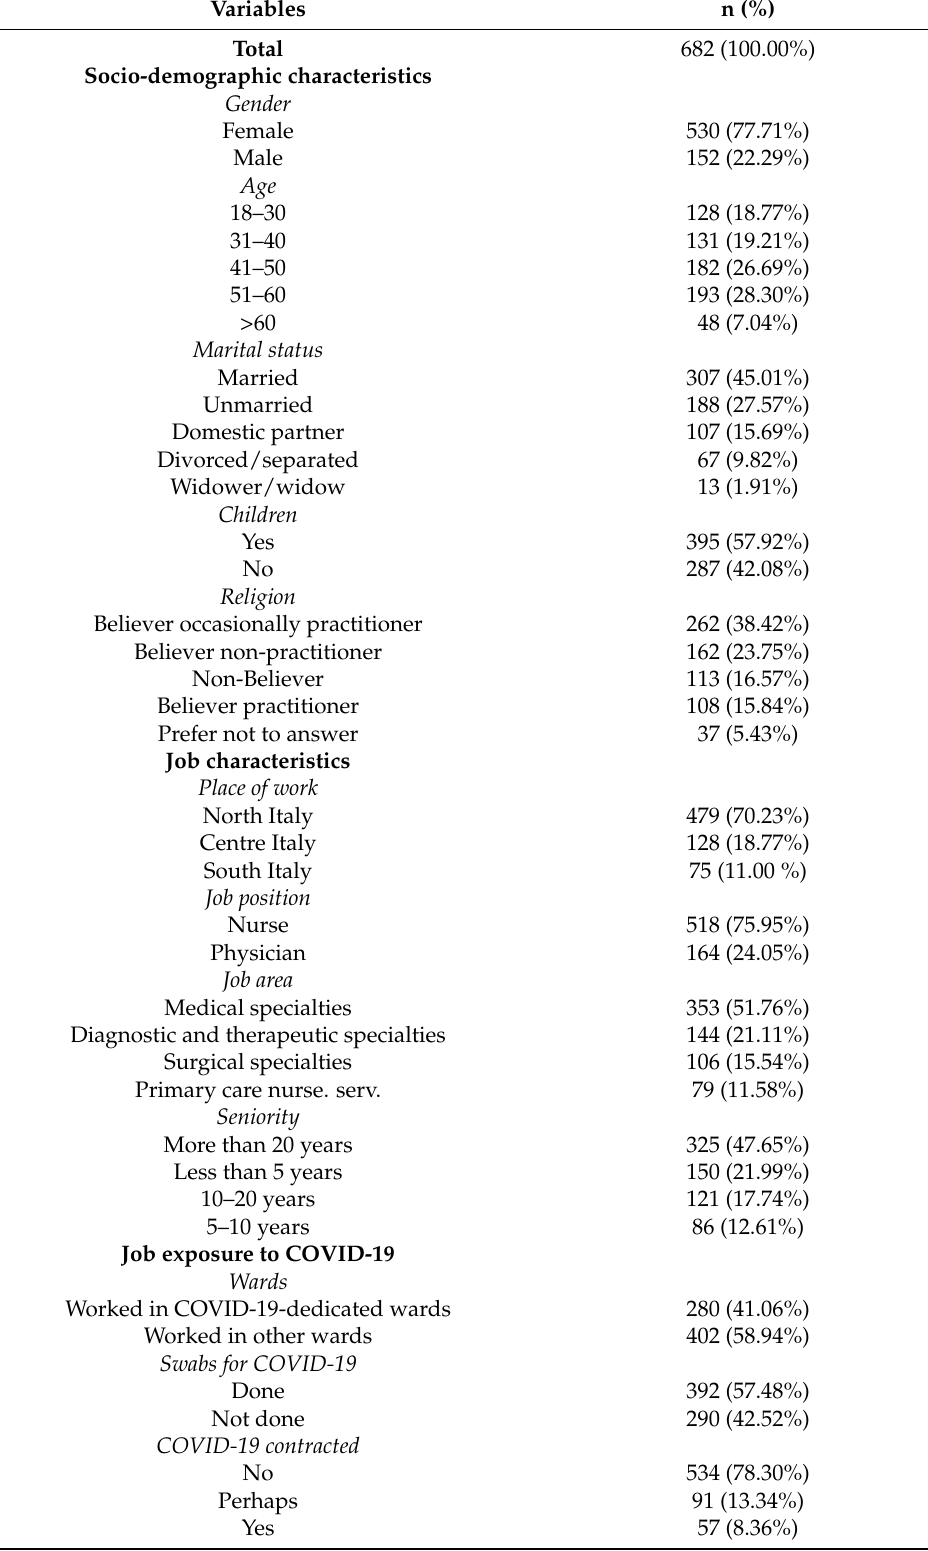
Table 1. Descriptive statistics of the sample